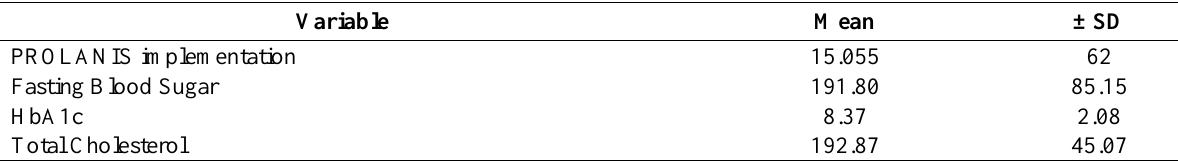
Table 2. Distribution of respondents by the Implementation of PROLANIS, Fasting Blood Sugar, HbA1c, and Total Cholesterol in Patient with Type 2 Diabetes Mellitus (n =